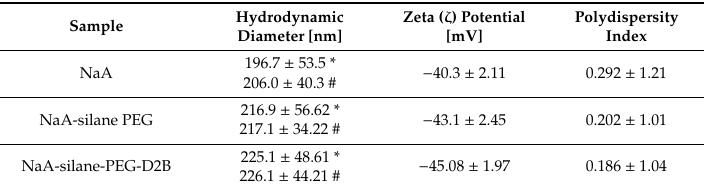
Table 4. Hydrodynamic diameter, zeta potential ( ζ ), and polydispersity index of the obtained samples (measured in PBS pH = 7.4). Hydrodynamic diameter is determined by the NTA method in RPMI 1640 medium (*) and in EMEM medium